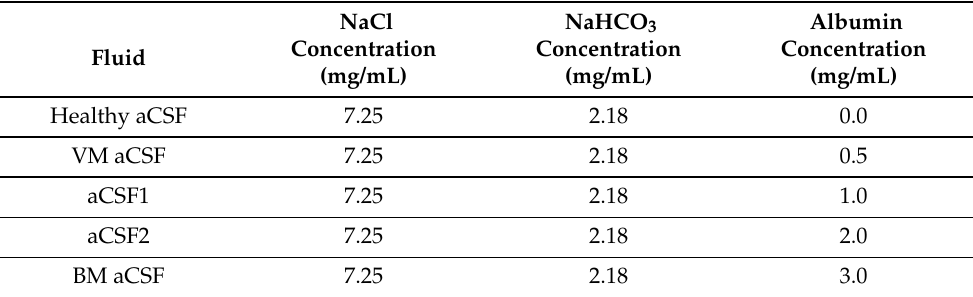
Table 2. Artificial Cerebrospinal Fluid (aCSF) compositions (error =